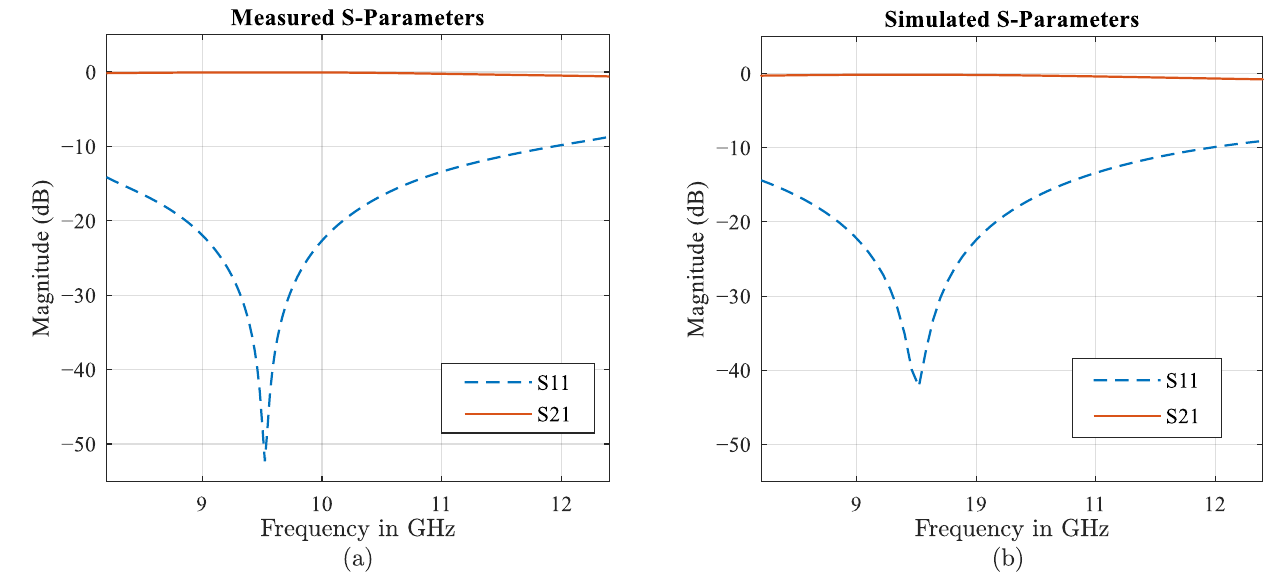
Figure 4. The de-embedded S11 and S21 of MUT from ( a ) measurement and ( b ) simulation.